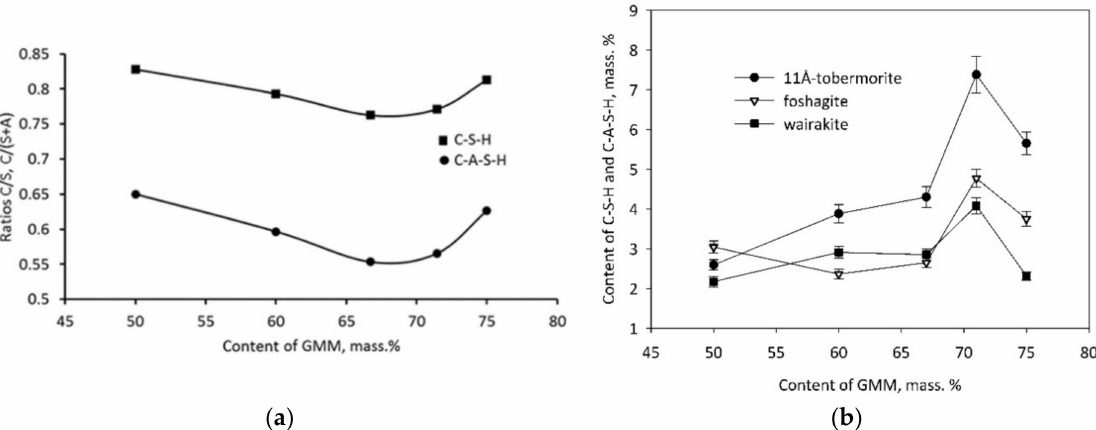
Figure 10. Effect of CaO/SiO 2 and CaO/(Al 2 O 3 + SiO 2 ) ratios in CaO–SiO 2 –H 2 O gel and CaO–Al 2 O 3 –SiO 2 –H 2 O gel ( a ) and content of newly-formed phases ( b ) on the binding system